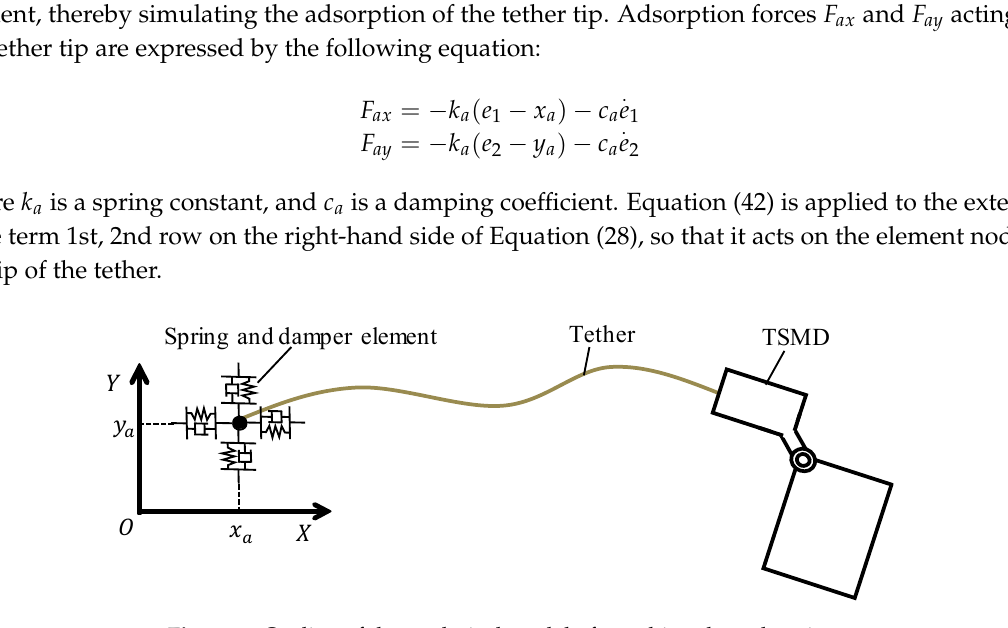
Figure 6. Outline of the analytical model of attaching the tether tip.